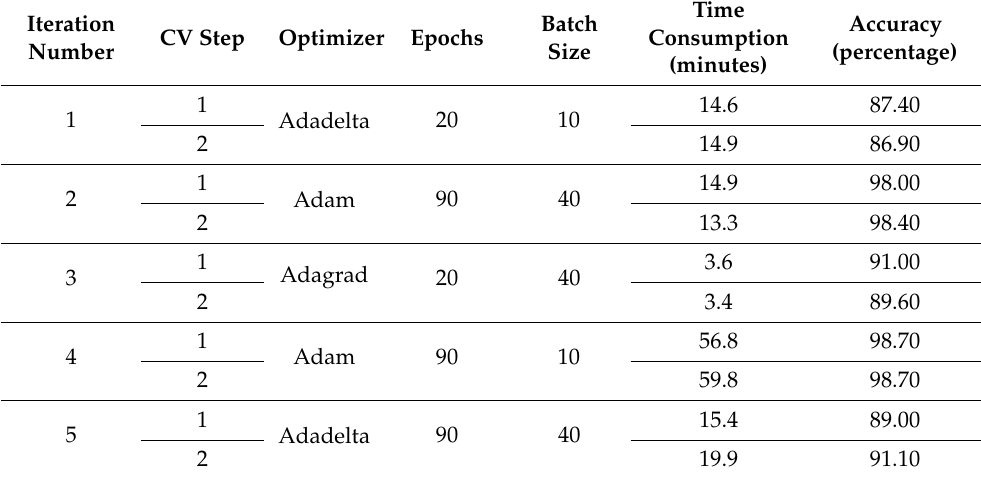
Table 5. Random search evaluation